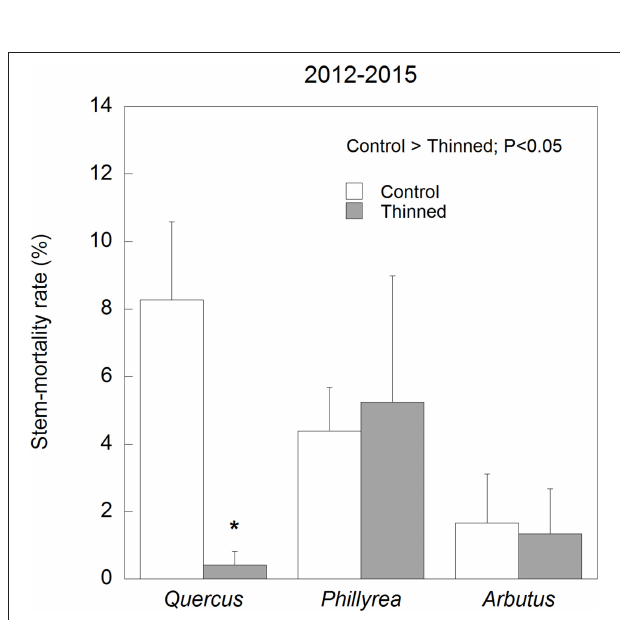
FIGURE 8 | Average differences in stem-mortality rates between the control and TDE plots in dry and wet years for each of the three species studied. Error bars correspond to the standard error of the mean ( n = 4). * P < 0.05.